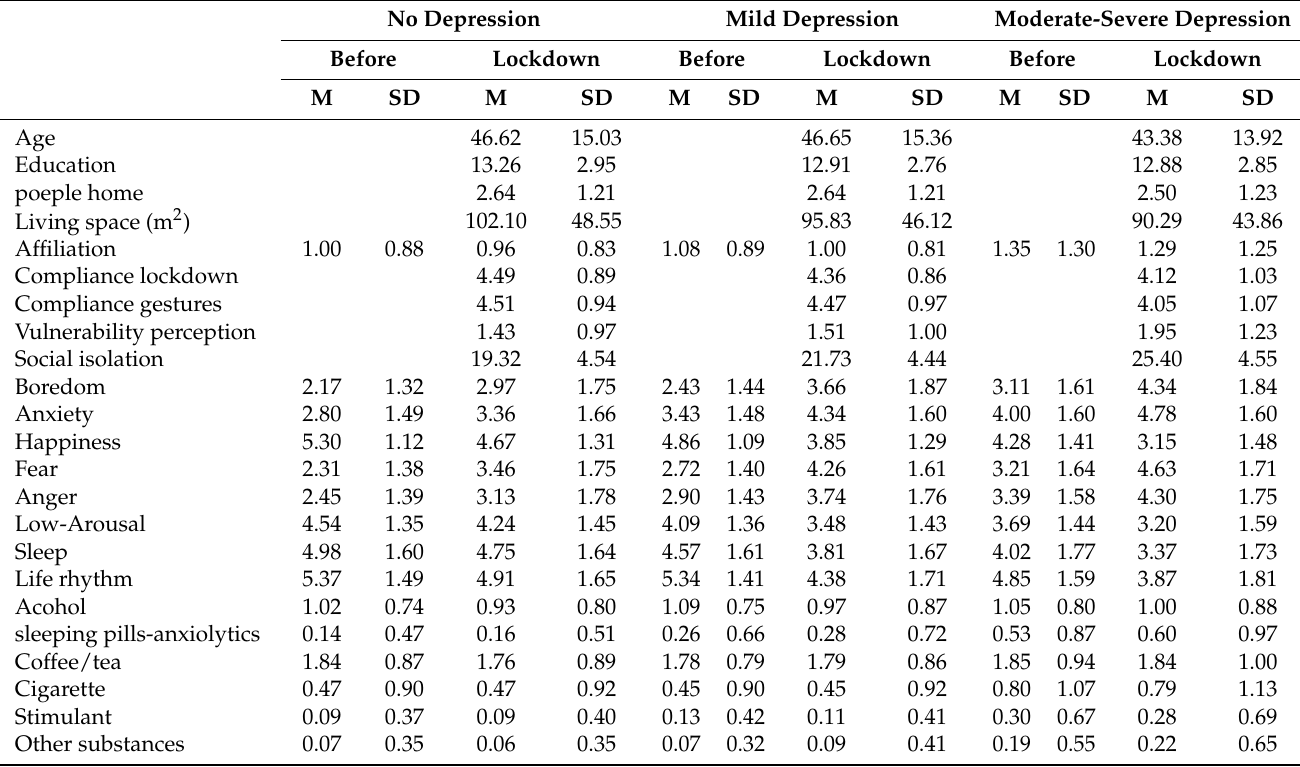
Table 3. Mean (SD) of the participants’ answers to the survey questions used in Study 2 according to depressive symptoms: no, mild and moderate-severe. No Depression Mild Depression Moderate-Severe